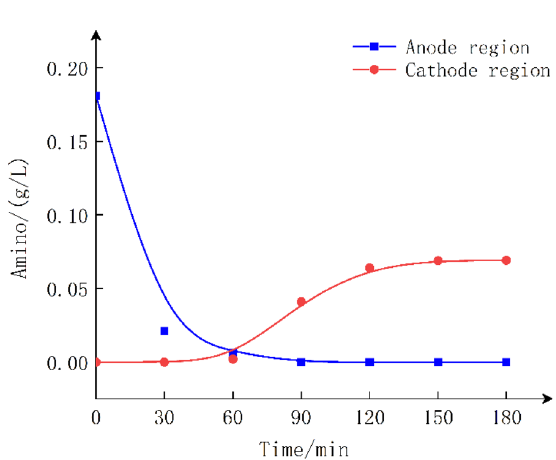
Figure 4. GlyGl migration vs time in the anode region under cationic